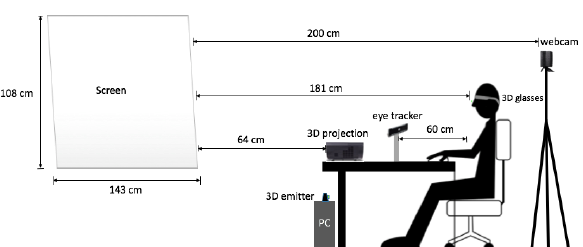
Fig.3. An illustration of experimental layout of the current study (Lin & Widyaningrum,